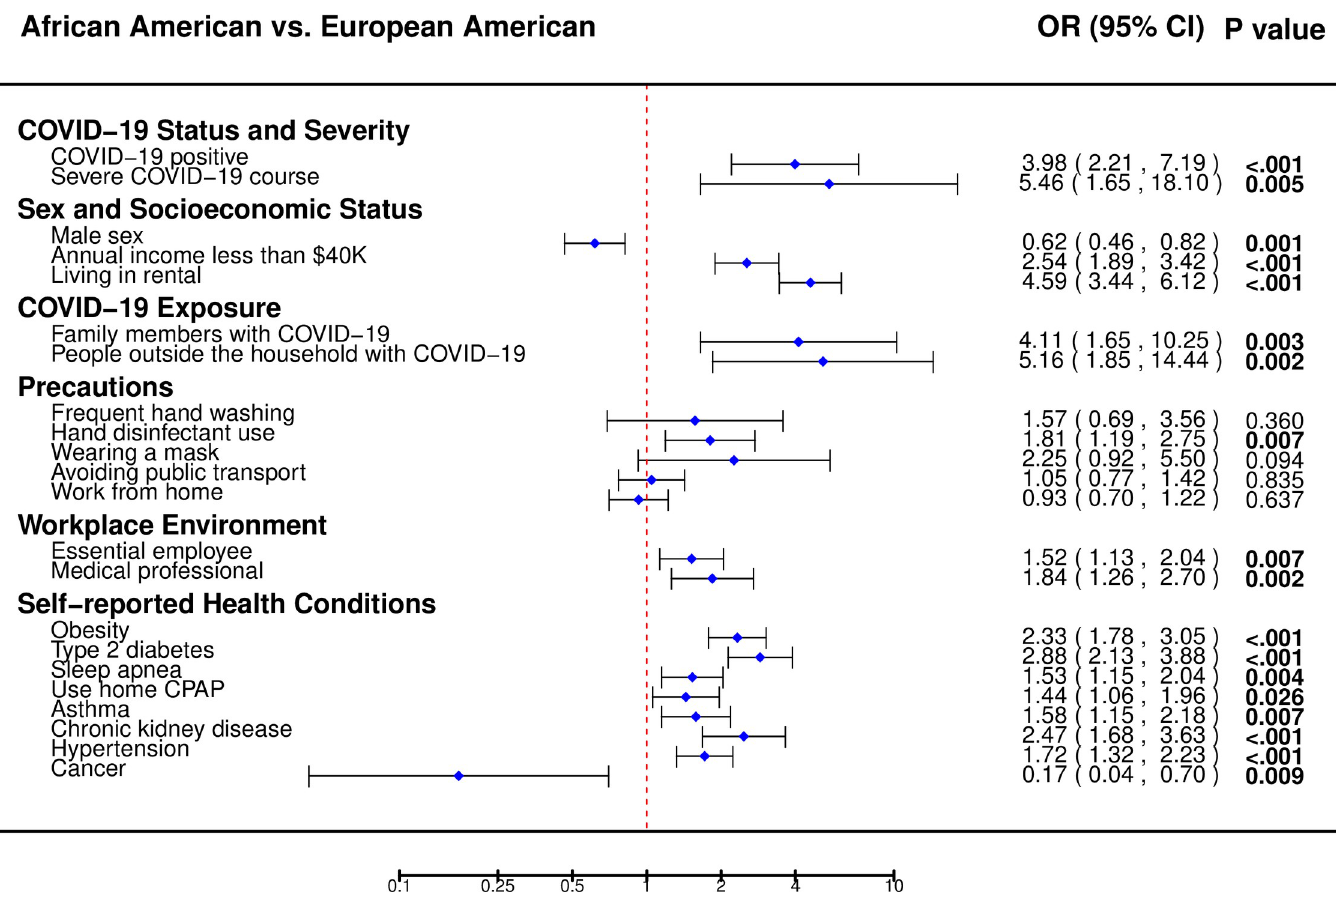
Fig 4. Differences in clinical and social risk factors between African American and European American survey respondents.